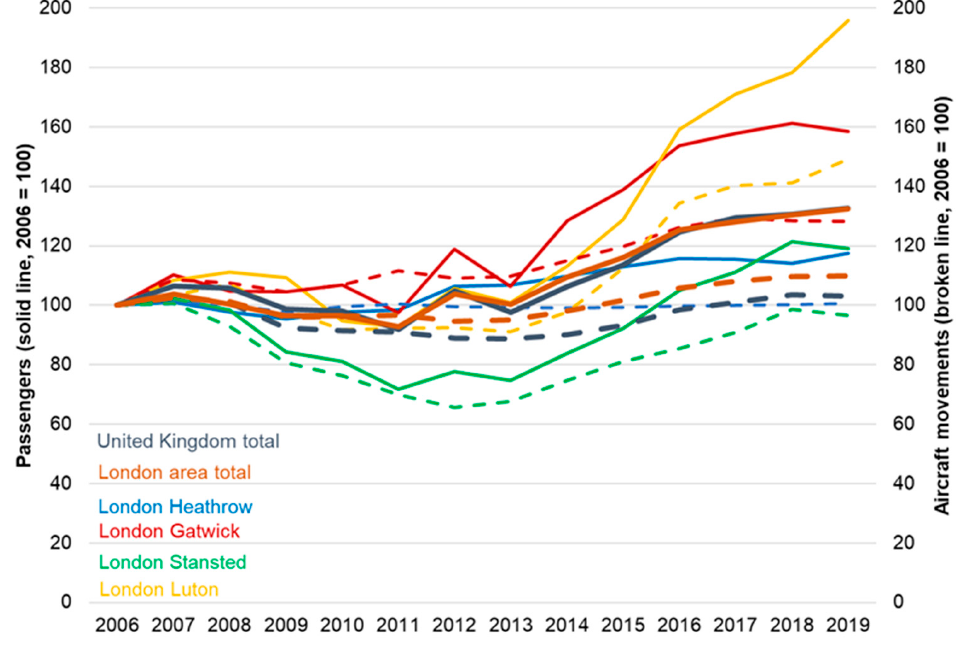
Figure 3. Relative development of passenger volume and aircraft movements at airports in the London area between 2006 and 2019 (2006 = 100). Reprinted from Ref. [7].